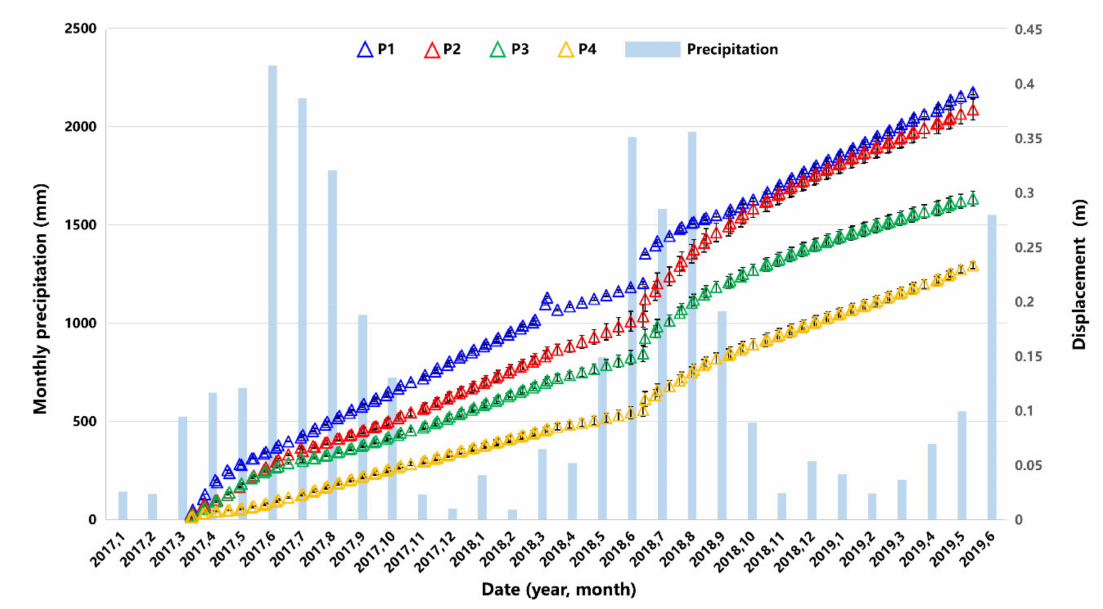
Figure 10. The displacement time series with optimal sliding direction for points P1–P4 (marked in Figure 7b) of the Baobao landslide during March 2017 to May 2019 against monthly precipitation. The error bars indicate the standard deviations of the time series derived using the Kalman